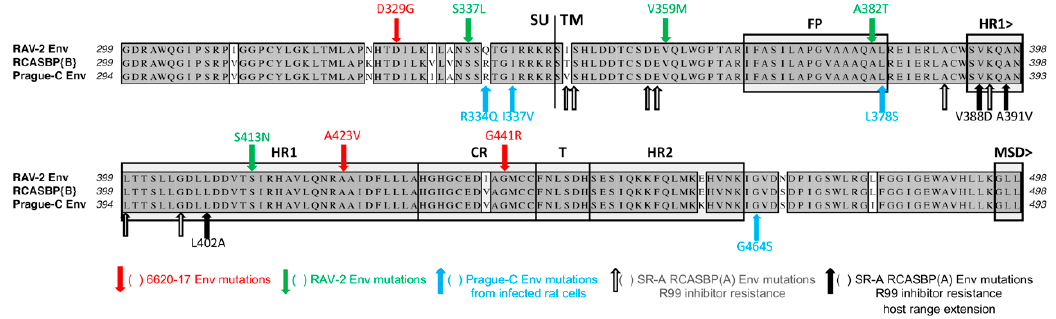
Figure 9. A summary and comparison of the ASLV c-terminal SU and N-terminal TM glycoprotein wild type and escape mutations identified using various genetic-based selections strategies limiting the entry and subsequent production of replication-competent ASLVs. Comparison of the C-terminal end of SU and N-terminal end of TM glycoproteins of RAV-2, RCASBP(B)SR-A, and Prague C. The sequence alignments were done using the ClustalW program in MacVector 14.5.3: identical residues are shaded; conserved residue differences are in boxes, and nonconserved residue differences are unmarked.